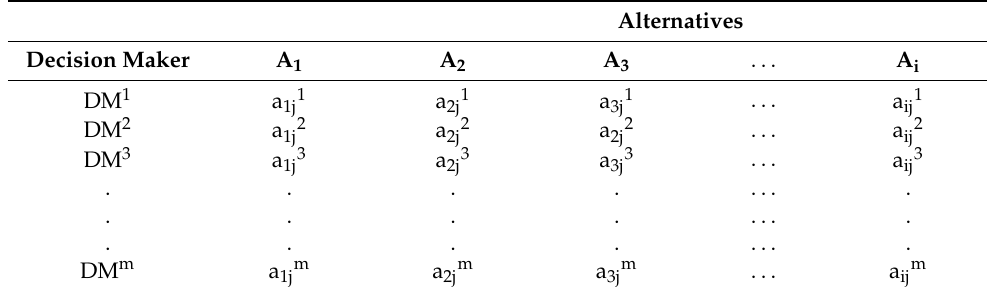
Table 3. Optimization matrix for individual